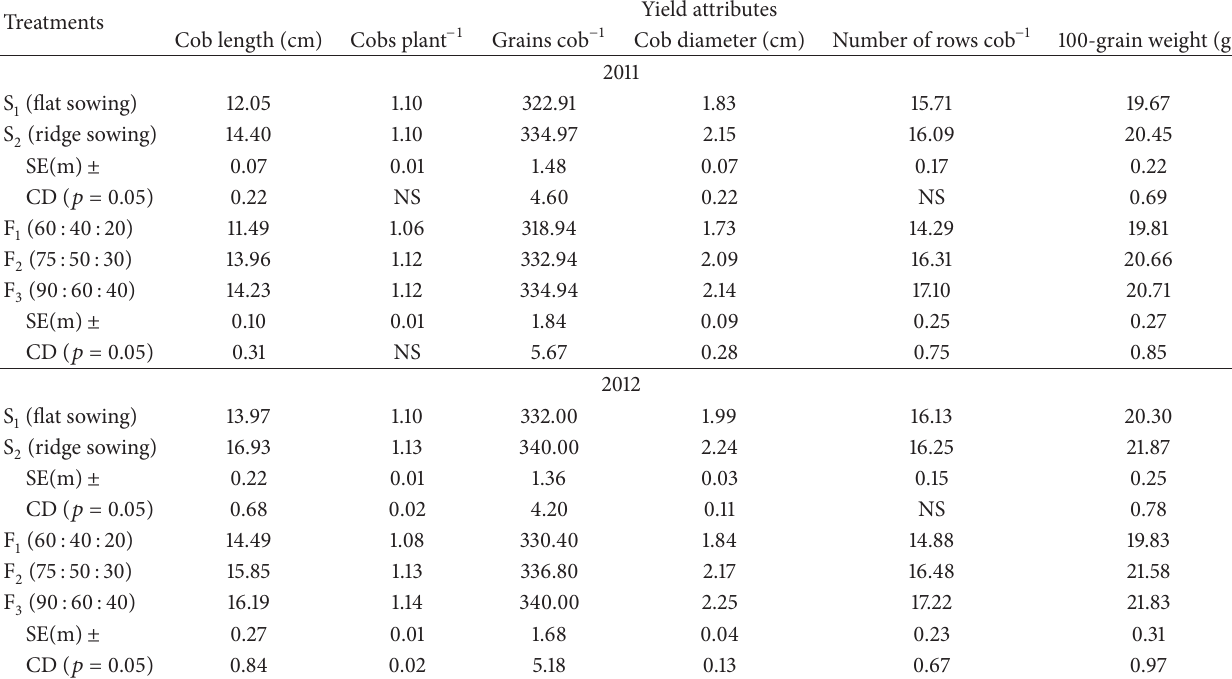
Table 2: Yield contributing characters of maize as affected by sowing methods and NPK levels. Treatments